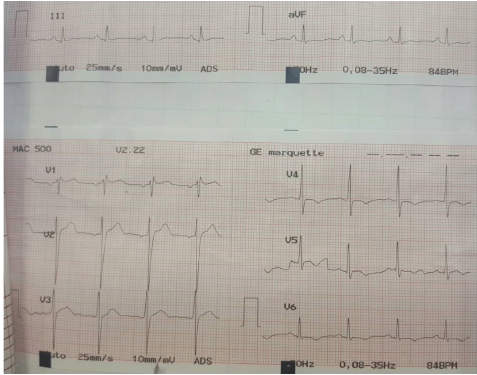
Figure 1. ECG of